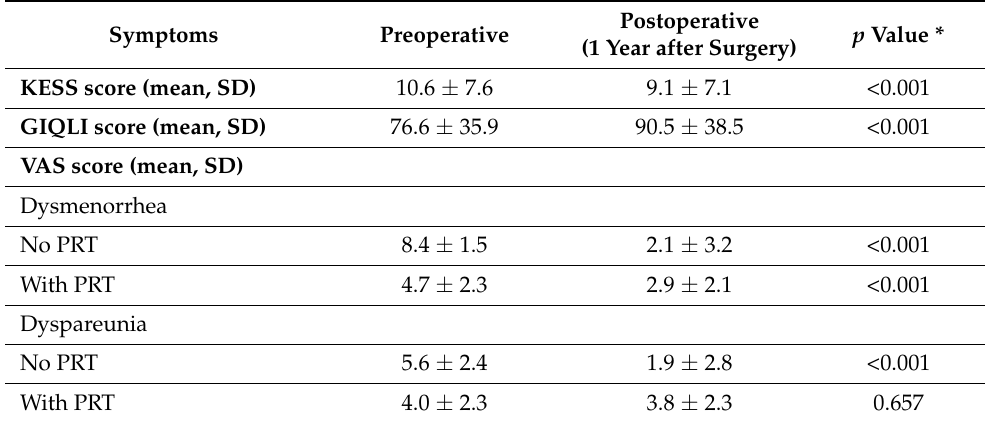
Table 3. Preoperative and postoperative KESS, GIQLI and VAS scores.